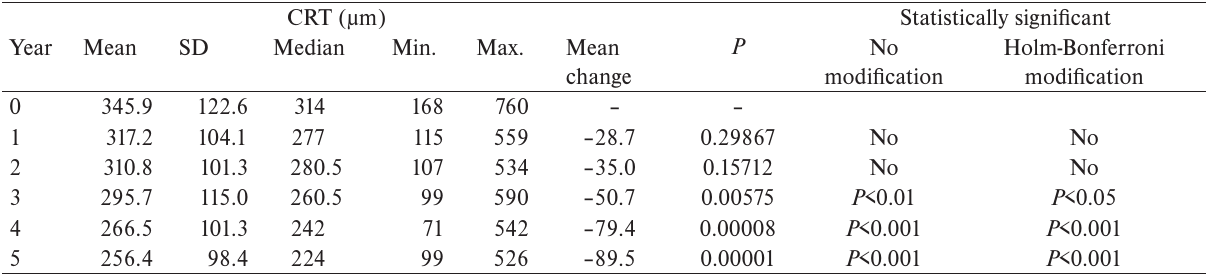
Table 1. Central retinal thickness (CRT) (µm), 5-year long monitoring and evaluation of the change CRT from the beginning.